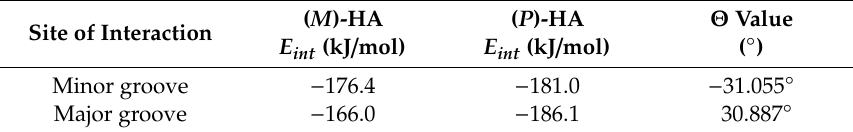
Table 1. Values of the interaction energy, E int , in kJ / mol calculated in the optimized geometries assumed at the end of MD run performed by two enantiomers studied for two di ff erent final geometries and the Θ